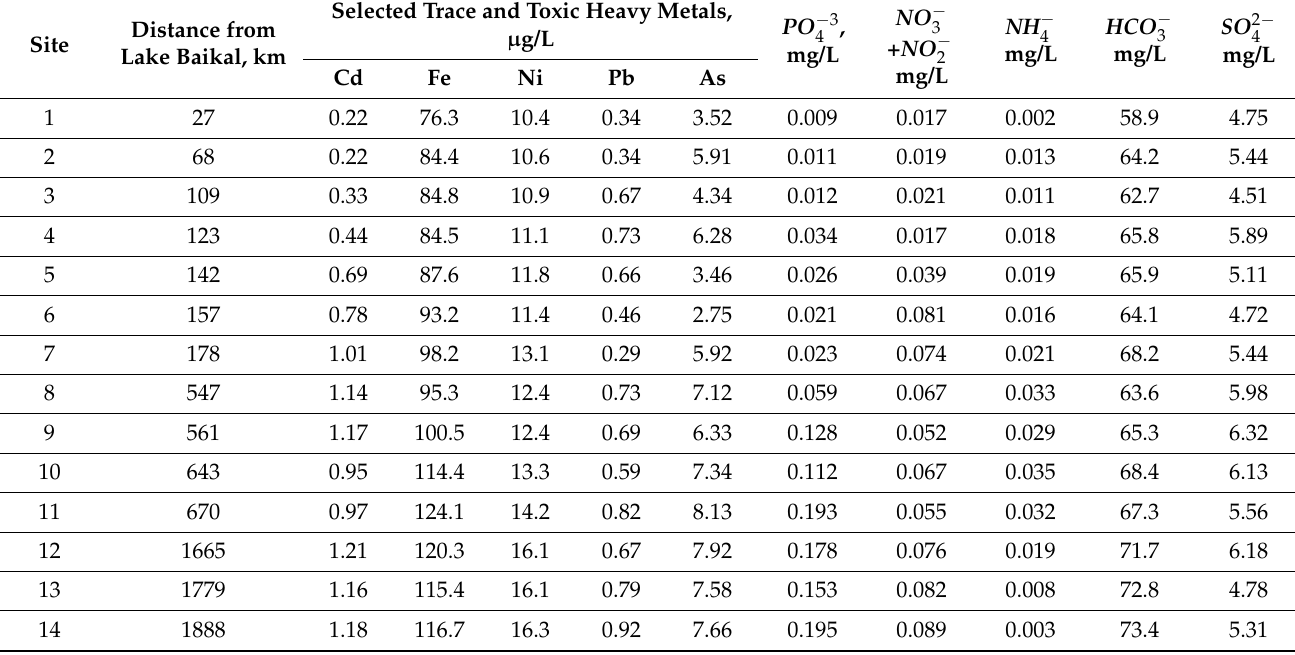
Table 4. Average hydrochemical parameters of the Angara River evaluated during the 2019 expedition. Distance from Site